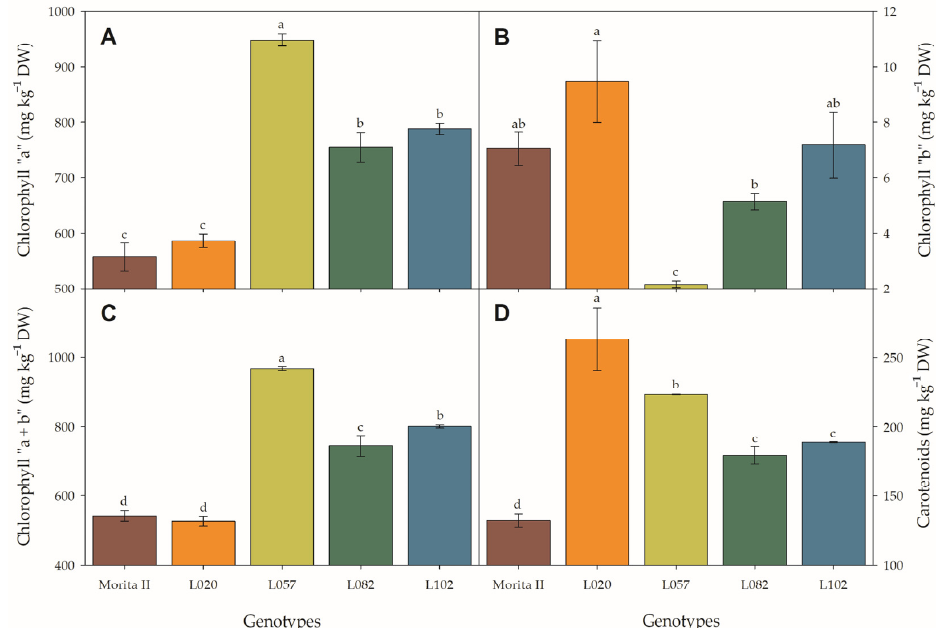
Figure 6. Chlorophyll a ( A ), chlorophyll b ( B ), total chlorophyll ( C ), and total carotenoids ( D ) evaluated in genotypes of Stevia rebaudiana (Morita II, L020, L057, L082, and L102) under land conditions in the complete absence of any plant stress. In each feature, means followed by different letters denote statistical significance ( p < 0.001). Means ± SD (n = 5).